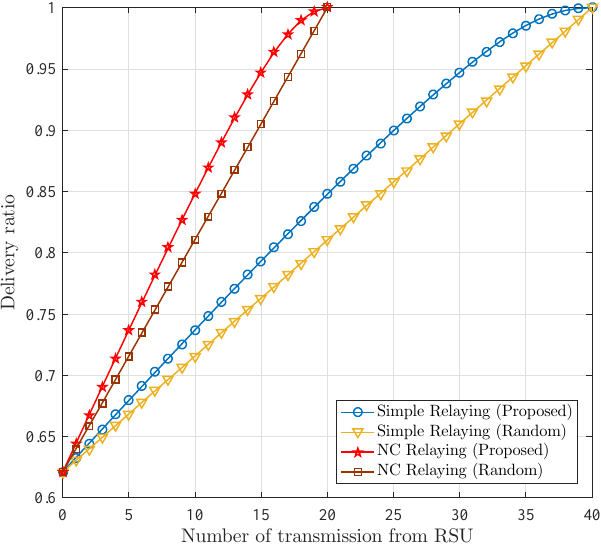
Figure 4. Delivery ratio of safety message with relaying, assuming collision-free communication (for N = 40).